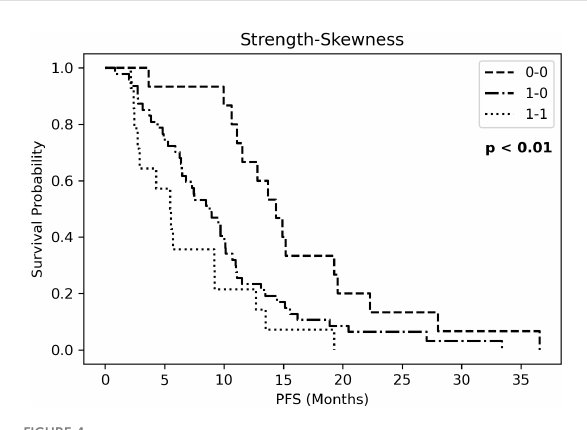
FIGURE 4 Kaplan Meier curves of progression-free survival (PFS) for three risk groups identi fi ed by Strength-Skewness (ST, Strength; SK,